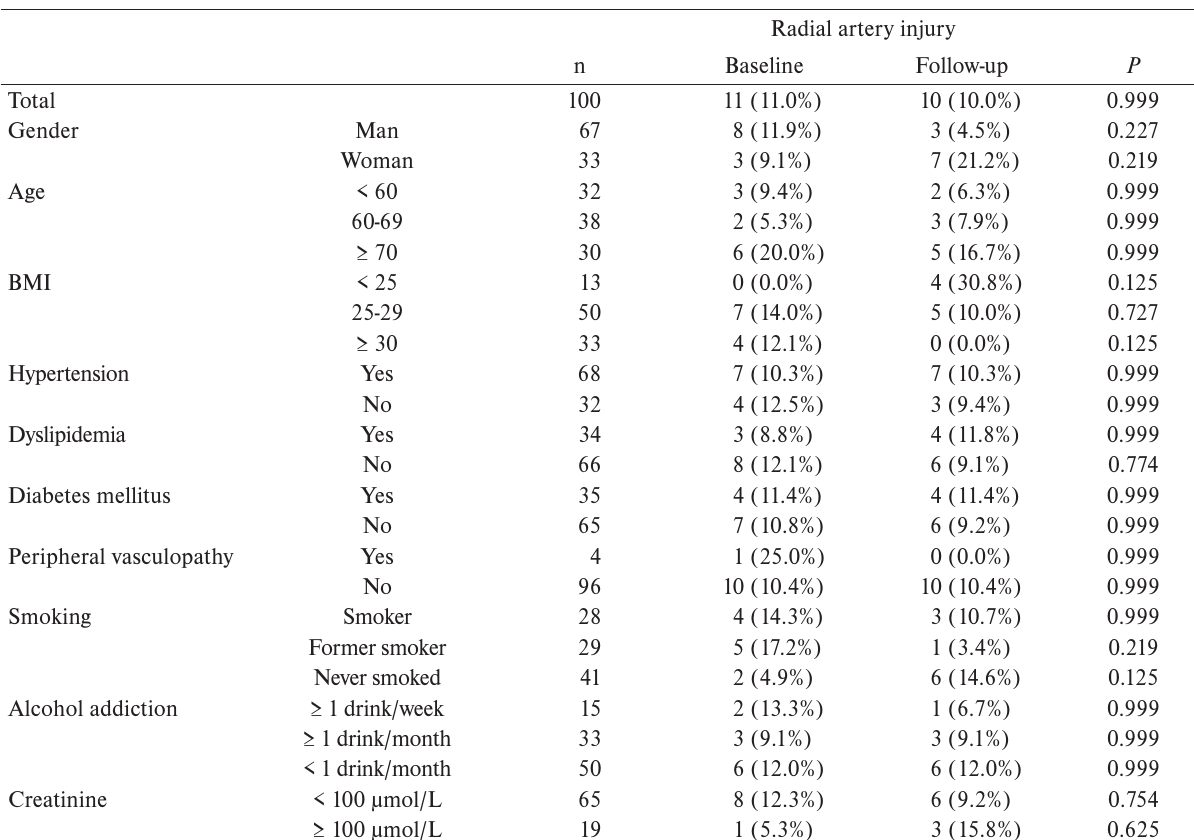
Table 4. radial artery